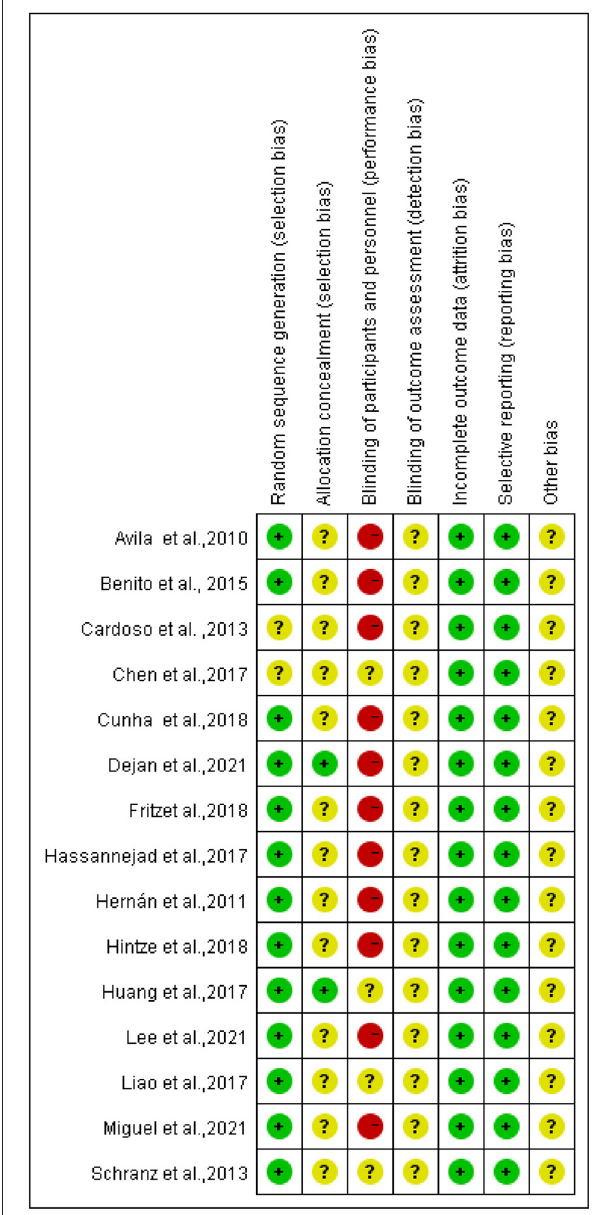
FIGURE 5 | Funnel plot of free-fat mass